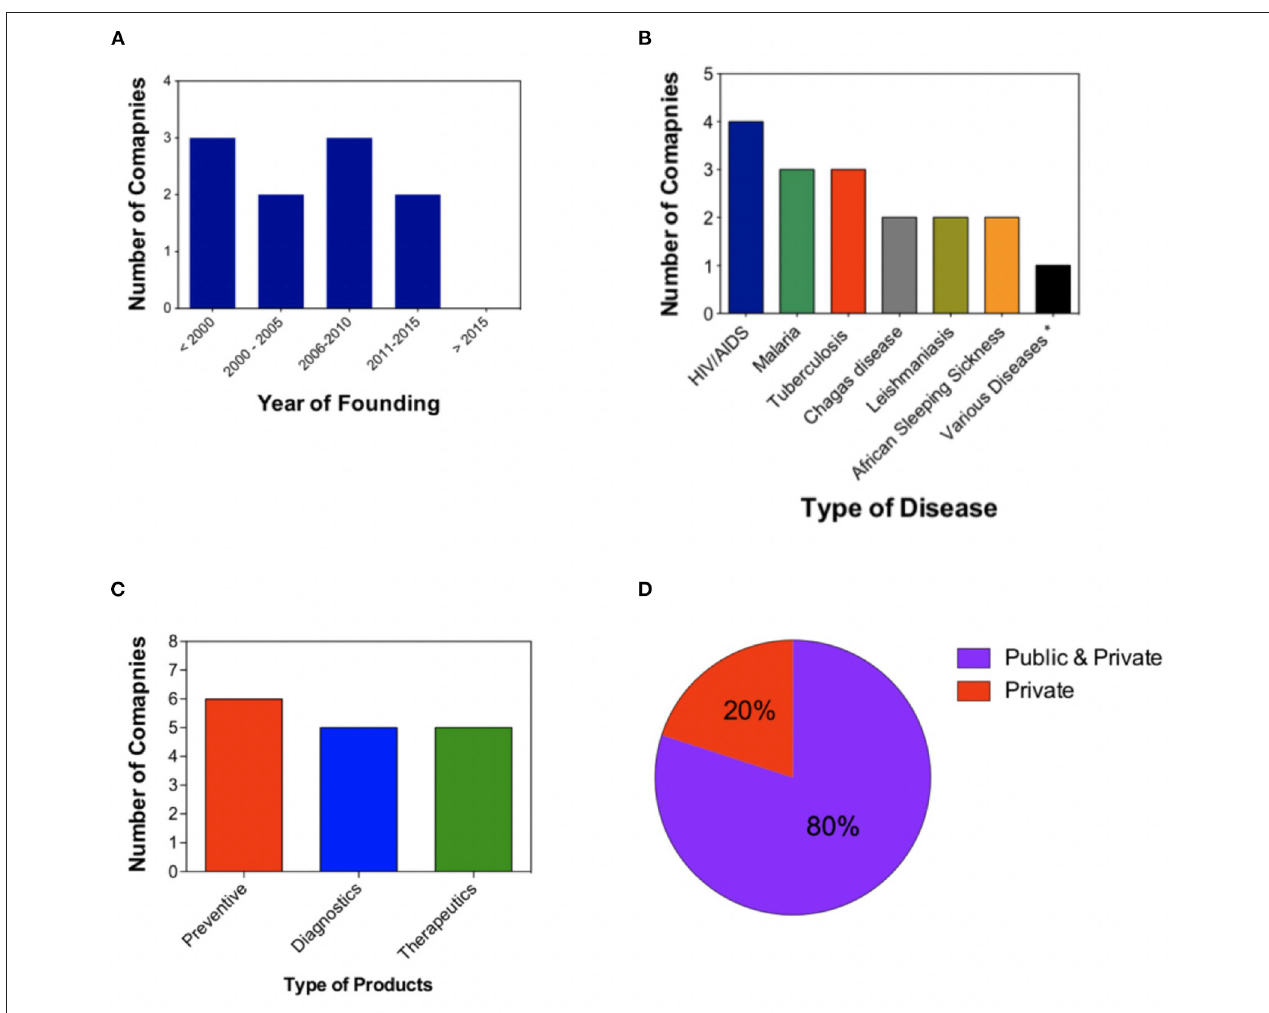
FIGURE 2 | A brief analysis of social biotechnology companies. (A) Year of founding of ten different social biotechnology companies. (B) Diseases of focus. Quantitative representation of the diseases of focus of non-profit biotechnology companies. (C) Distribution of the types of products (preventives, diagnostics, and therapeutics) developed by social biotechnology companies. (D) Quantitative representation of the analysis of partners. * Amebiasis, diabetes, child malnutrition, toxoplasmosis, onchocerciasis (river blindness), loiasis, human African trypanosomiasis (HAT), lymphatic filariasis, tetanus, measles, hypertension, and filarial